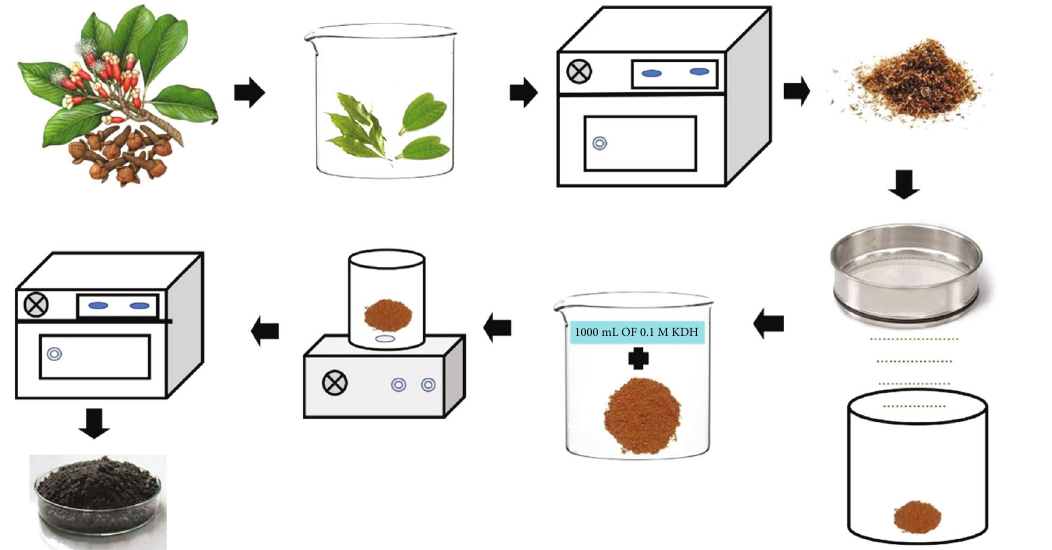
Figure 3: Steps for the synthesis of CL-KOH biosorbent for this